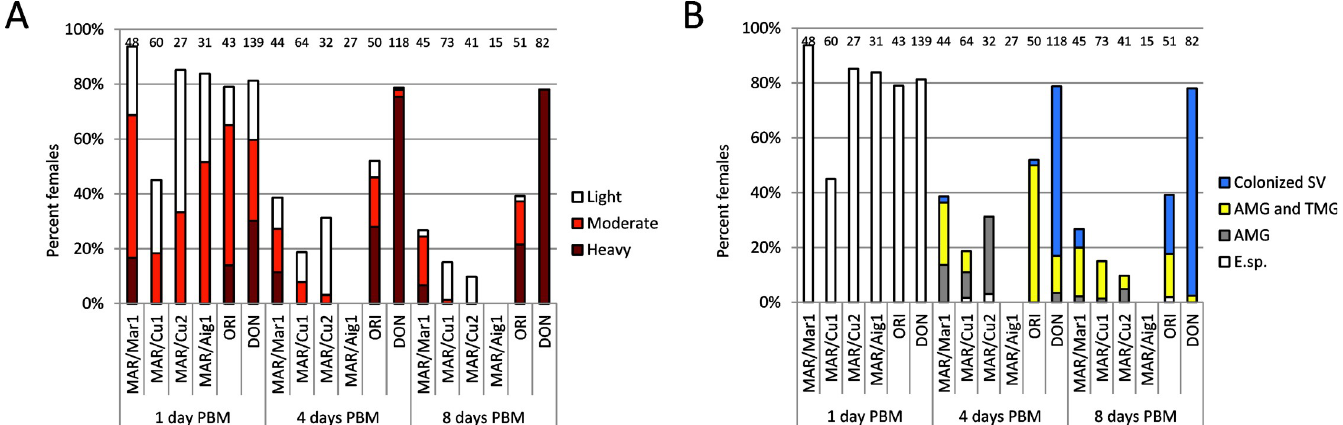
Fig 4. Leishmania development in the sand fly P . argentipes . Intensity (A) and localization (B) of L . martiniquensis (MAR; MAR1, Cu1, Cu2, Aig1), L . orientalis (ORI) and L . donovani (DON) infections assessed by light microscopy. SV, stomodeal valve; AMG, abdominal midgut; TMG, thoracic midgut; E. sp., endoperitrophic space; PBM, post blood meal. Intensity of infection (parasite load) was categorized as light, < 100 parasites per gut; moderate, 100–1000 parasites per gut and heavy, > 1000 parasites per gut. Numbers of dissected females are displayed above the columns. Differences among Leishmania species/strains were significant and increased from day 1 PBM (P < 0.0001, X 2 = 97.997, d.f. = 15) to day 4 PBM (P < 0.0001, X 2 = 207.642, d.f. = 15) and day 8 PBM (P < 0.0001, X 2 = 214.778, d.f. =